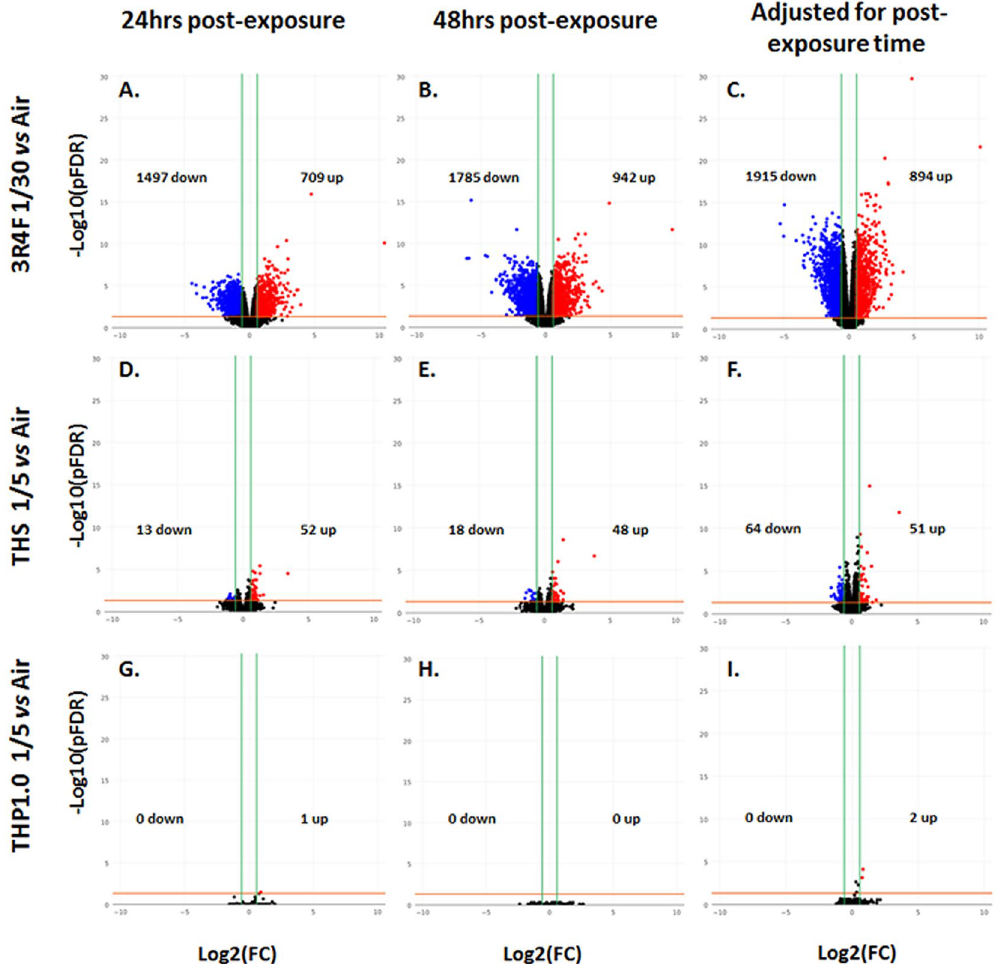
Figure 4. Volcano plots for the following 9 RNA-seq contrasts and RNAs significant at [FC] > 1.5, pFDR < 0.05: 3R4F smoke exposure vs the air control presented in the top 3 volcano plots presenting the differential expression at 24 hrs post-exposure ( A ) the differential expression at 48 hrs post-exposure ( B ) and the differential expression adjusted for post-exposure time ( C ). The center volcano plots correspond to THS aerosol exposure vs the air control presenting the differential expression at 24 hrs post-exposure ( D ), the differential expression at 48 hrs post-exposure ( E ) and the differential expression adjusted for post-exposure time ( F ). The bottom volcano plots show the THP1.0 aerosol exposure vs the air control with the differential expression at 24 hrs post-exposure ( G ) the differential expression at 48 hrs post-exposure ( H ), and the differential expression adjusted for post-exposure time ( I